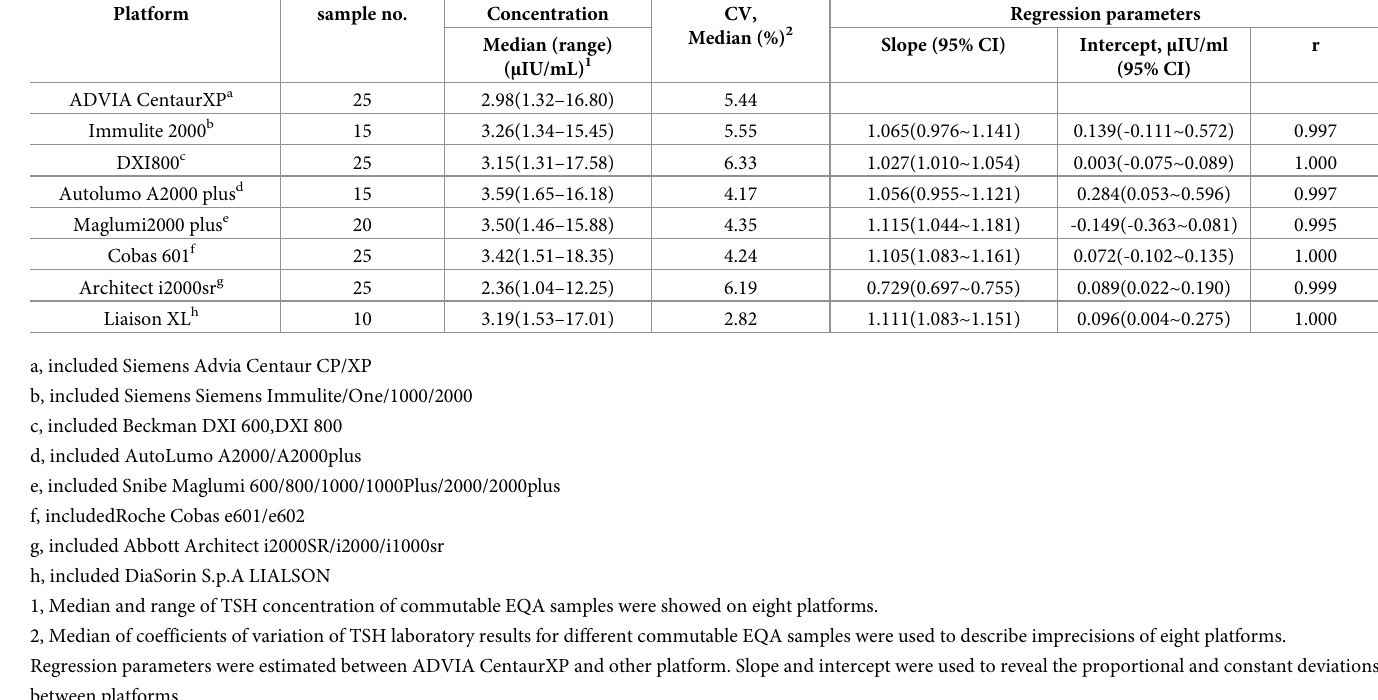
Table 3. Passing–Bablok regression analysis measured TSH values using commutable EQA materials (2017~2019). Platform sample